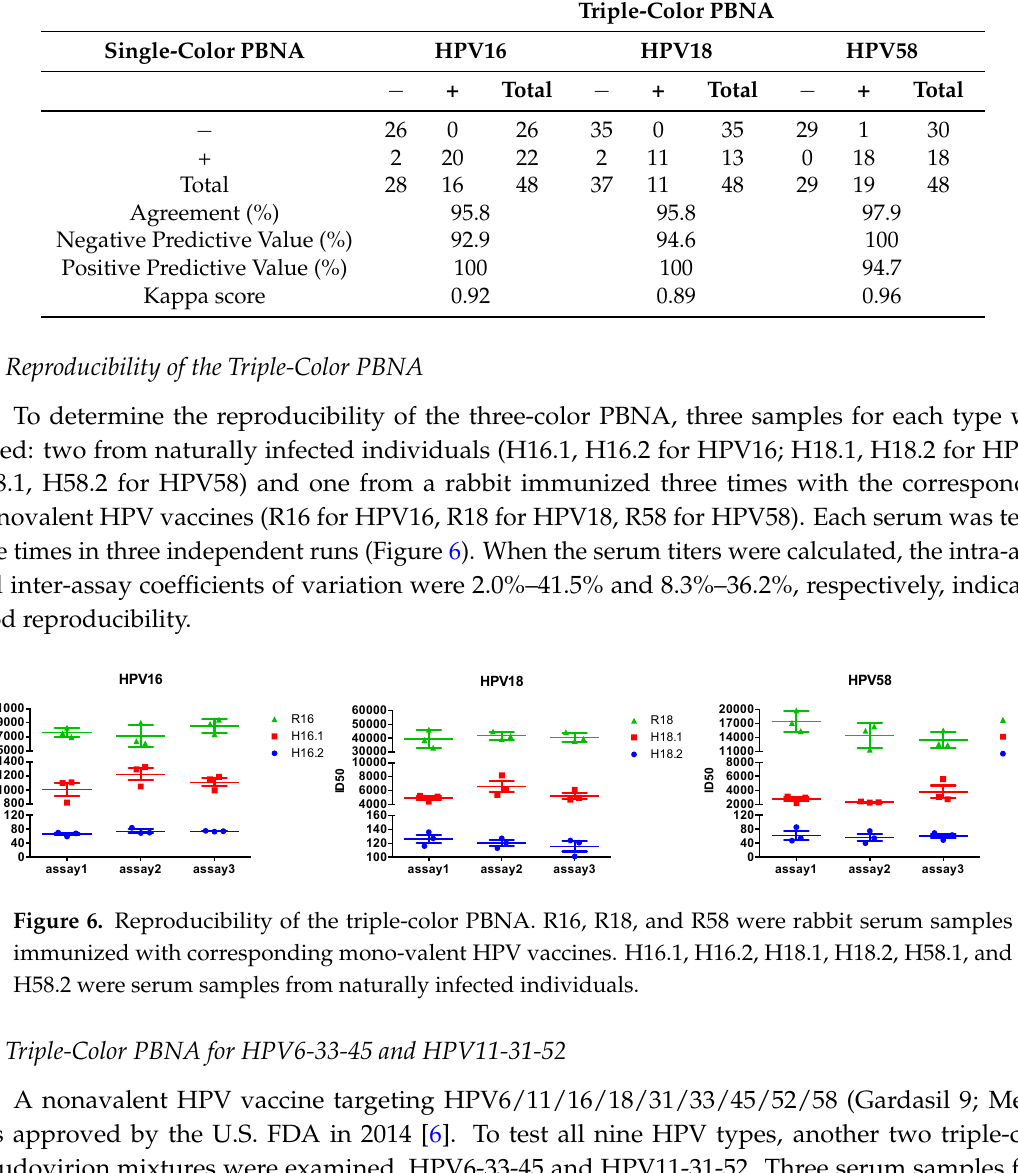
Table 2. Agreement between the single- and triple-color PBNAs in a naturally infected cohort. Triple-Color PBNA